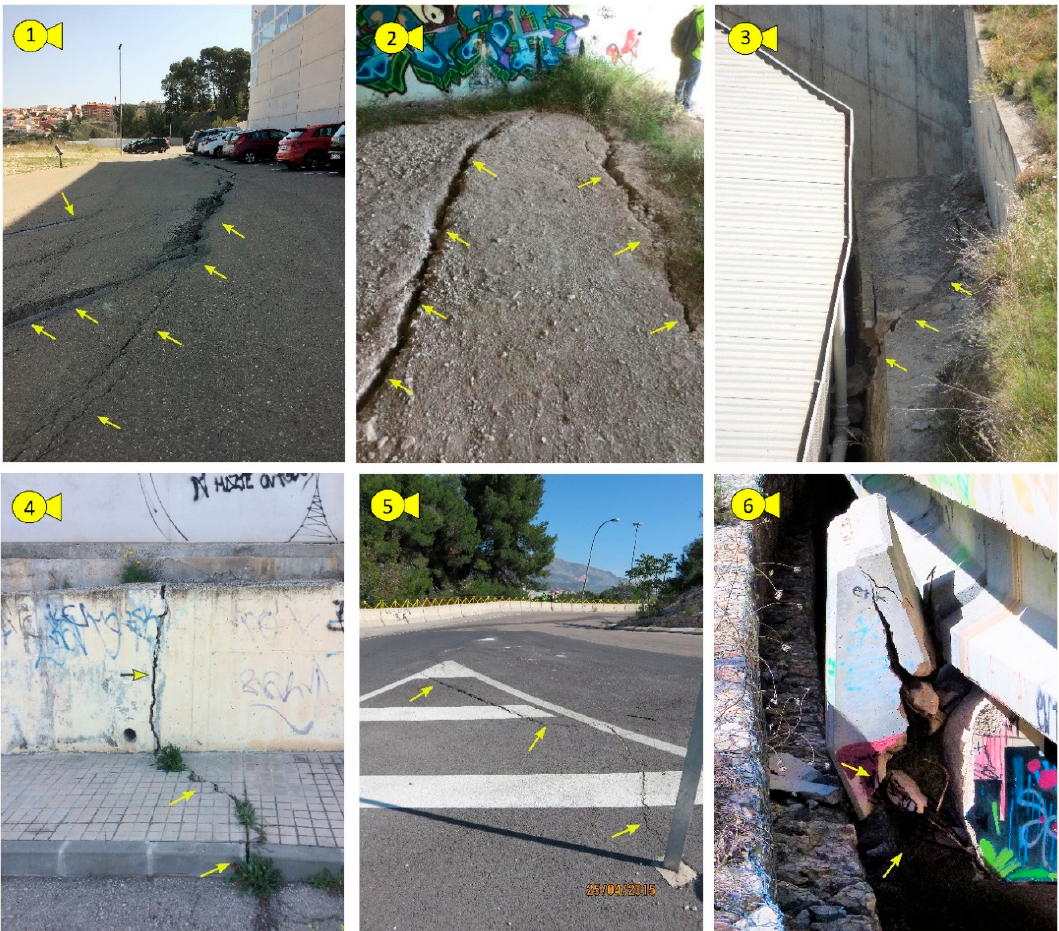
Figure 6. Photography of damages. ( 1 ) Crack at the head of the slope. ( 2 ) Crack on the soil surface beneath the bridge. ( 3 ) Broken wall at the bottom of the slope. ( 4 ) Cracked concrete fence located north of the bridge. ( 5 ) Crack on the pavement at the roundabout, north of the bridge and tilting of the lamppost. ( 6 ) Shear key broken because of precast beam lateral movement. Photos location are shown in Figure 1.